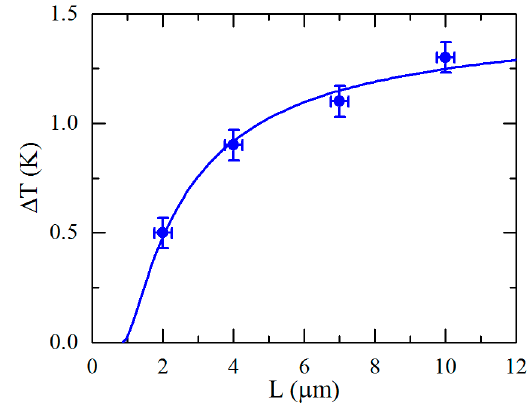
Figure 10. Dependence of the temperature width of the Sm-A and Hex-B coexistence region on the LC film thickness. The solid line shows the result of fitting with the analytical equation ∆ T ∝ ( 1 − L 0 / L ) 2 , where L 0 ≈ 0.9 µ m is the characteristic length scale (adopted from Zaluzhnyy et al. [70]). Reproduced with permission of American Physical Society.